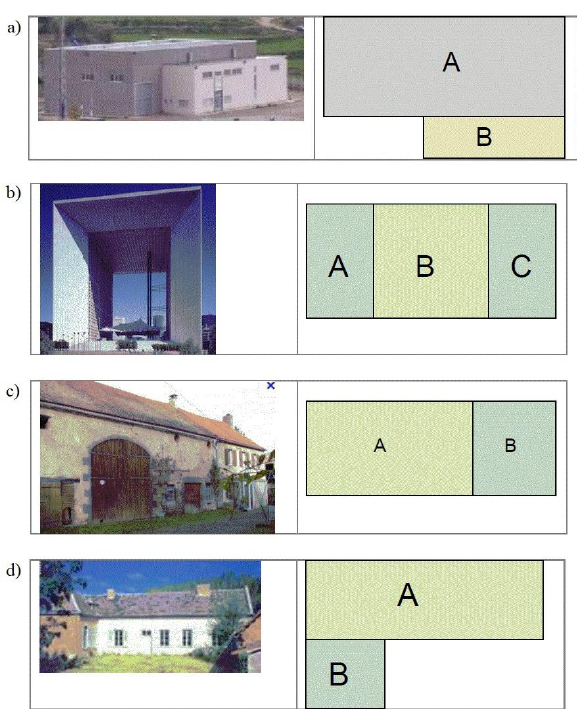
Figure 1. Building parts examples from the INSPIRE Building